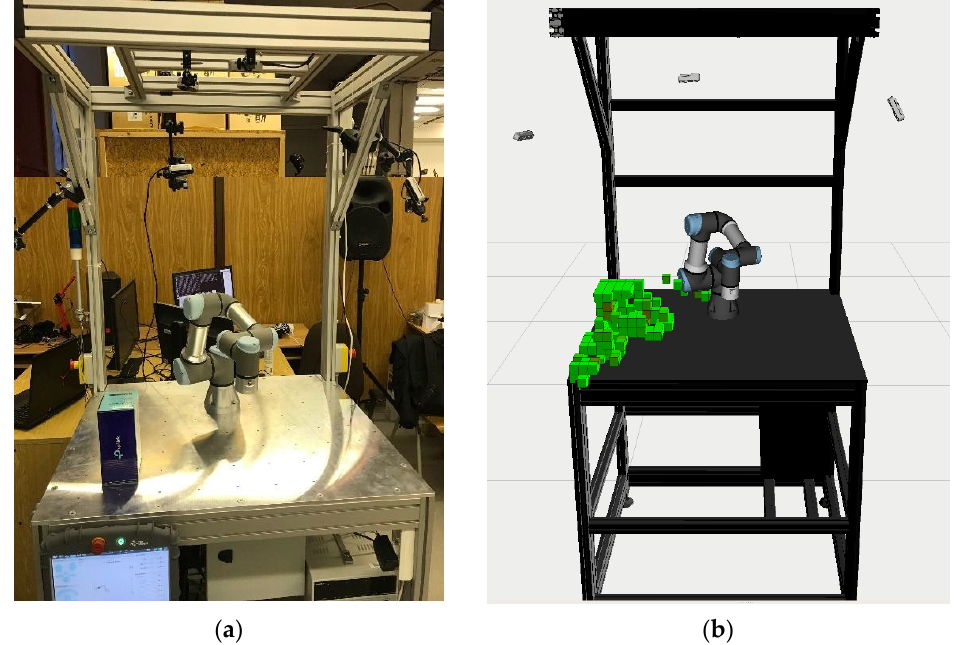
Figure 1. Demonstration image of the output from MoveIt! filtration: ( a ) real workspace; ( b ) simulation.